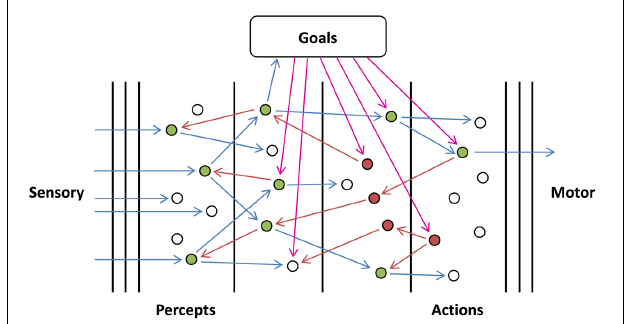
FIGURE 2 | Goal-directed Network. An illustration of the proposed cortical architecture. Sensory, feedforward input (left) is mapped to percepts, actions, and finally motor responses (right), and this mapping is controlled by goal-dependent feedback (top). In the diagram, blue, red, and magenta arrows correspond to feedforward, internal feedback and external feedback (feedback corresponding to the goals of the system) connections, respectively. It should be noted that only the connections from active or searching units have been shown and they would exist other connections which have not been shown. White, green, and red units correspond to resting, active, and searching units, respectively.